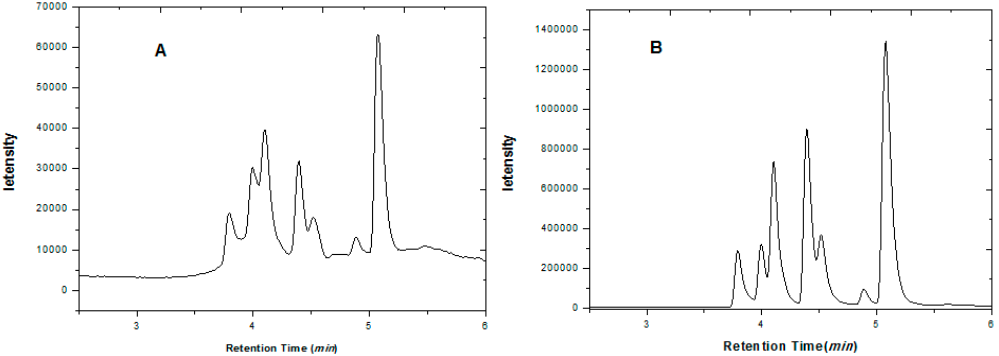
Figure 7. The chromatogram of coumarin and its derivatives before ( A ) and after ( B ) purification by Cleanert PSA.